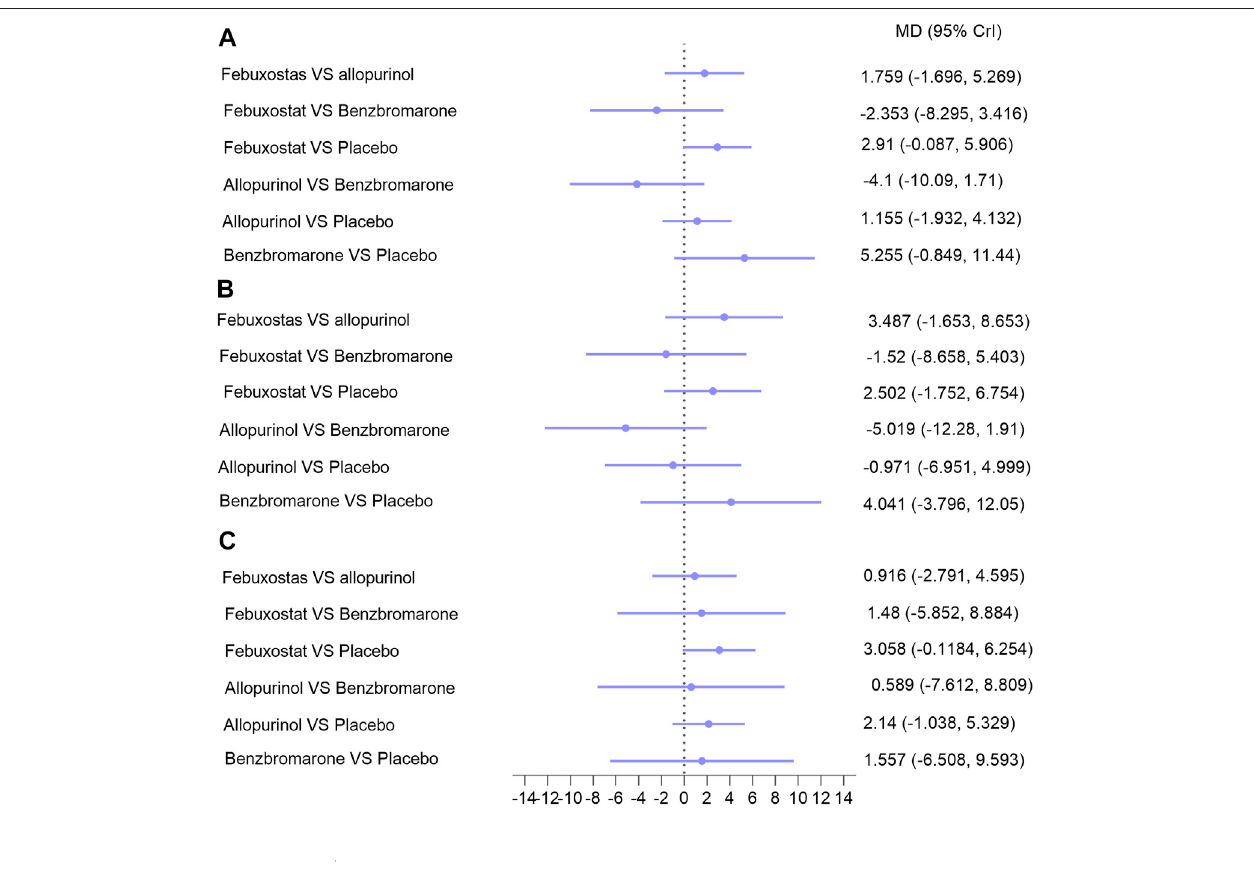
FIGURE 4 | Network meta-analysis results for lowering eGFR decline in (A) patients with CKD; (B) patients with hyperuricemia and CKD; (C) patients with hyperuricemia and eGFR < 60 ml/min/1.73 m 2 . Abbreviations: MD, mean difference; CrIs, credible intervals; CKD, chronic kidney disease; eGFR (ml/min/1.73 m2), estimated glomerular fi ltration rate.